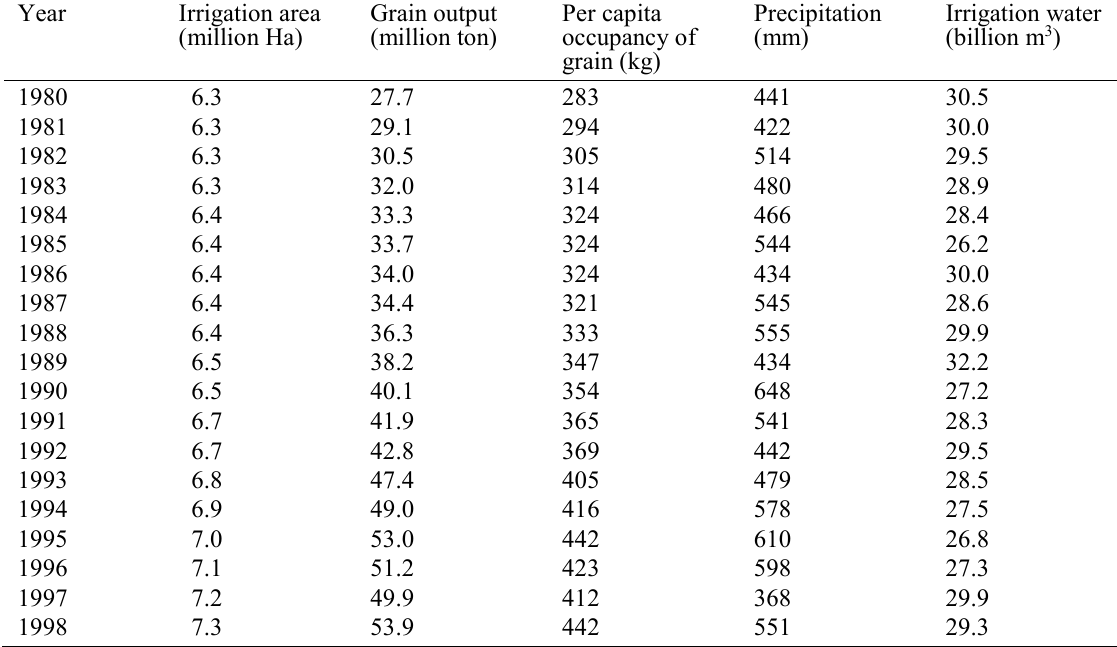
Table 1 Agricultural indicators of Haihe River basin in 1980–1998.